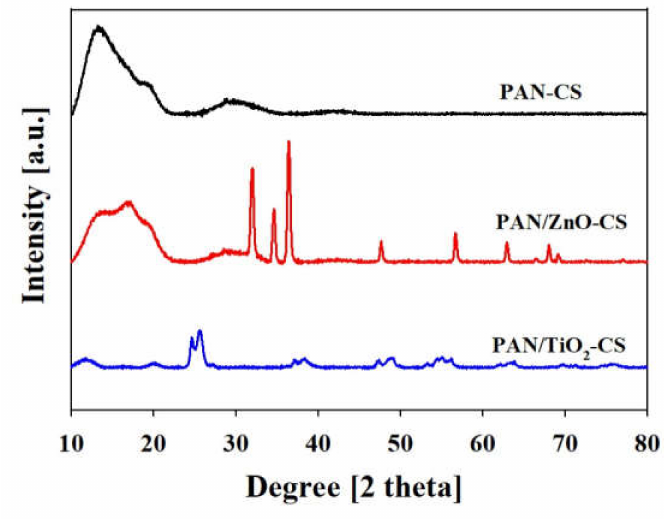
Figure 2. XRD analysis of the bilayer